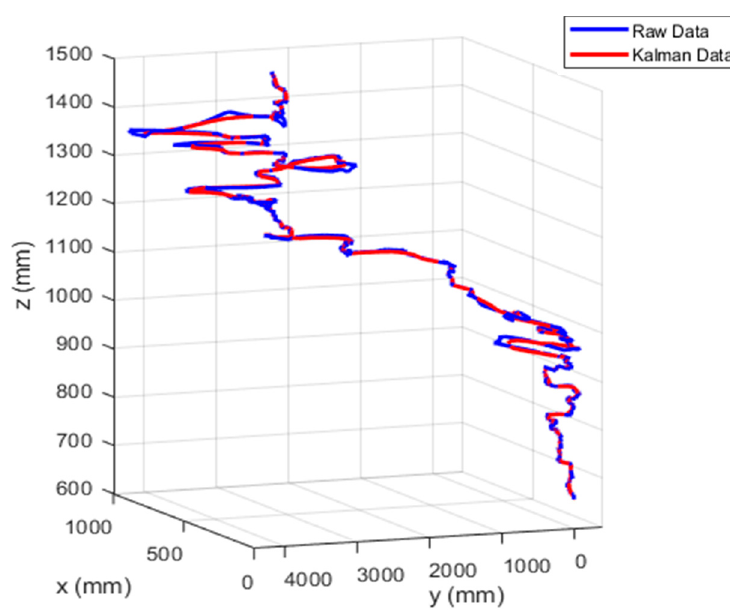
Figure 15. Landing from a 150-cm height to ground.